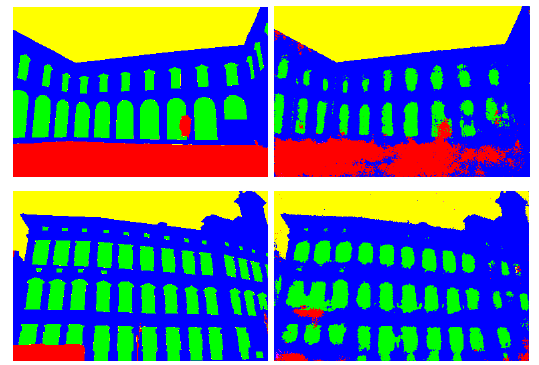
Figure 5: Ground truth labels (left) and testing (right) results.